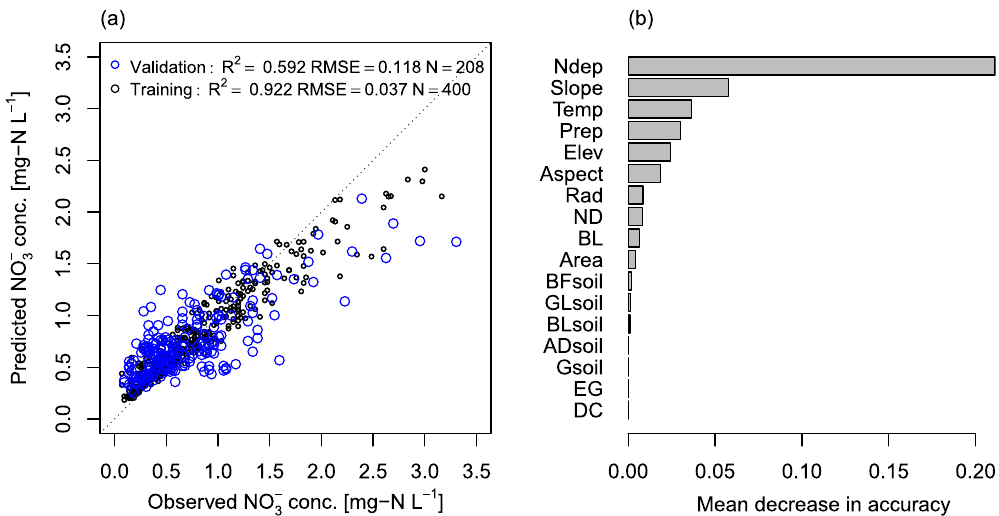
Figure 3. Predicted versus observed values of − NO and, variable of importance to the − NO mean decrease in